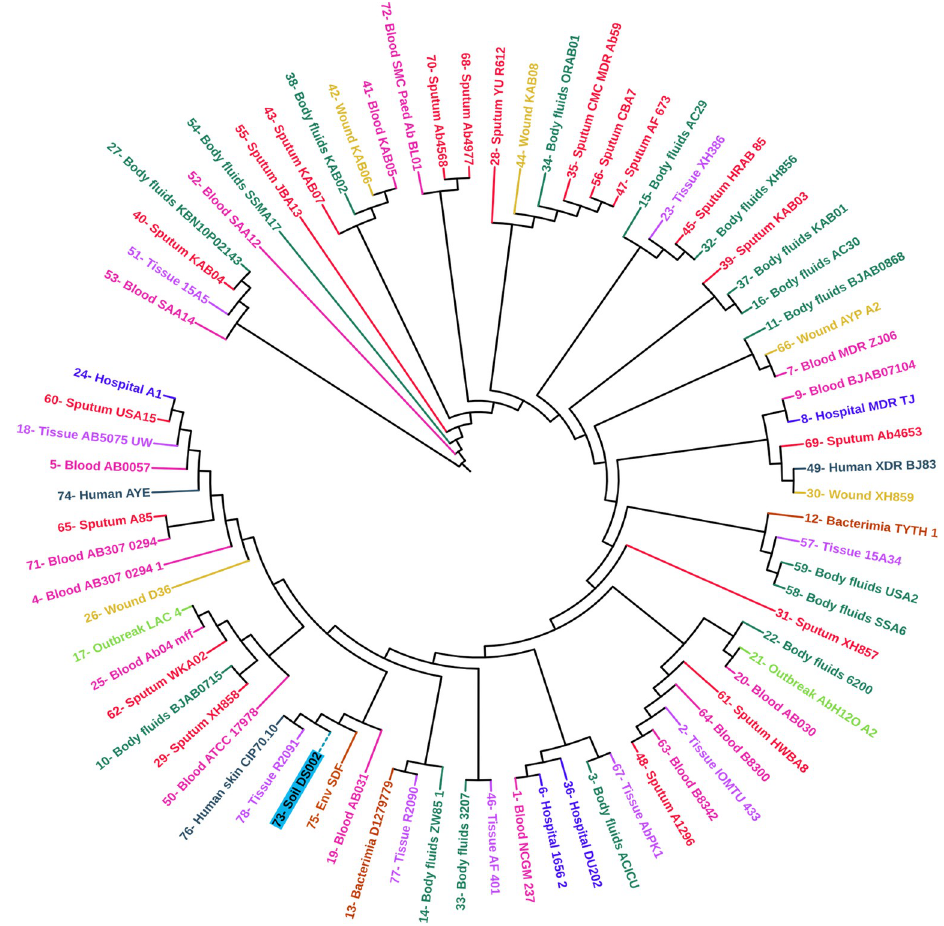
Fig 2. Phylogenetic tree. Core genome-derived phylogenetic tree of 78 A . baumannii strains. The position of DS002 in the phylogenetic tree is highlighted with a blue background and dotted clade line.